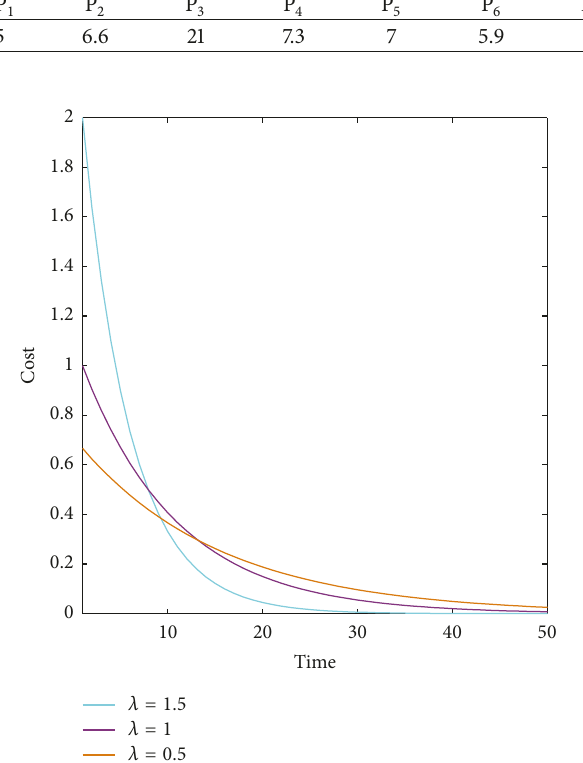
Figure 4: Relationship between cost and due dates.